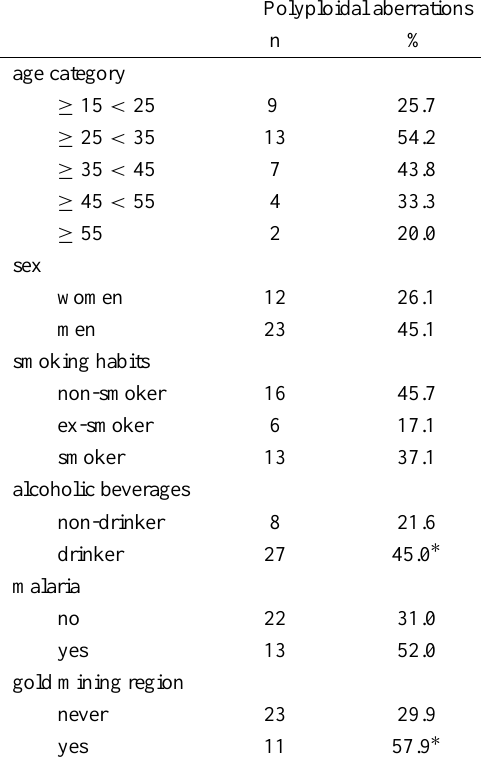
Distribution of persons with polypoidal aber- rations with respect to the characteristics of the study